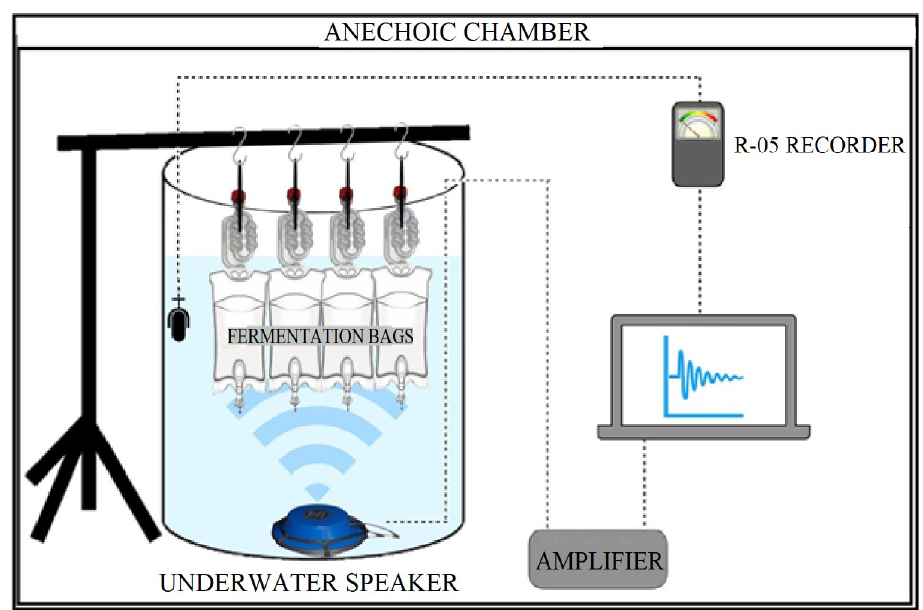
Fig 7. Sound experimental setup. Fermentation vessels were suspended, and acoustically isolated, from a microphone stand by rubber bands. These vessels were submerged in a 115 L plastic barrel. For each sound treatment, three biological replicates and one uninoculated control were suspended within the barrel. Sound treatments were applied to fermentations using an underwater speaker, connected to an amplifier and computer. The sound volume was recorded using a calibrated hydrophone and adjusted using the computer volume control to the appropriate intensity. The entire experimental setup was placed within the University of Auckland’s anechoic chamber. Multiple barrels (not shown) were able to be placed within the anechoic chamber simultaneously. Diagram is not to